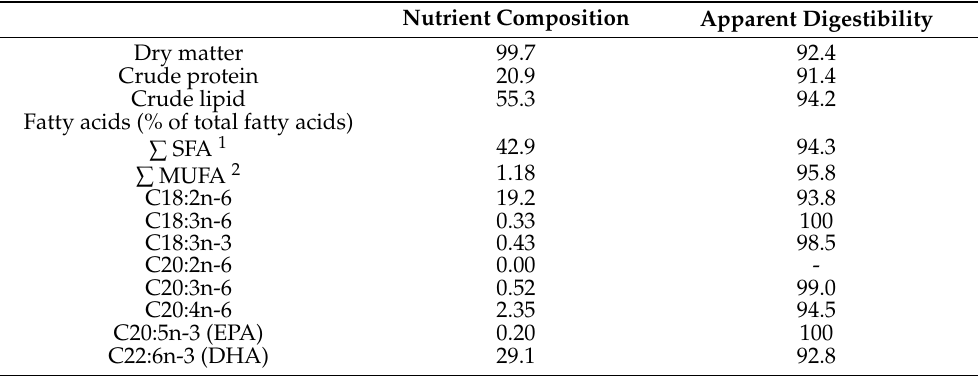
Table 1. Nutrients composition and apparent digestibility coefficients of Schizochytrium sp. (% dry matter basis).